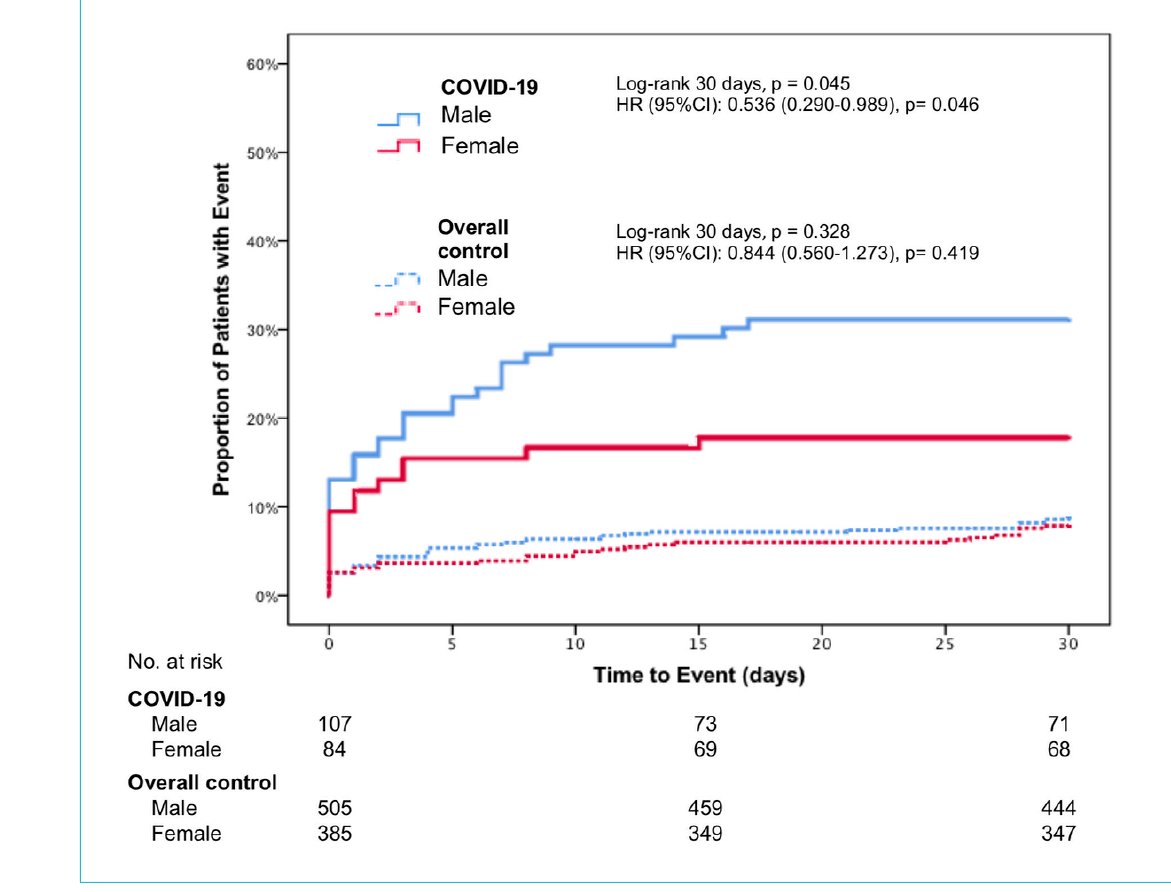
Figure 1: Composite outcome of admission to ICU, rehospitalization for respiratory complication and death within 30 days in COVID-19 cases and overall control; depicted hazard ratios (HR) are